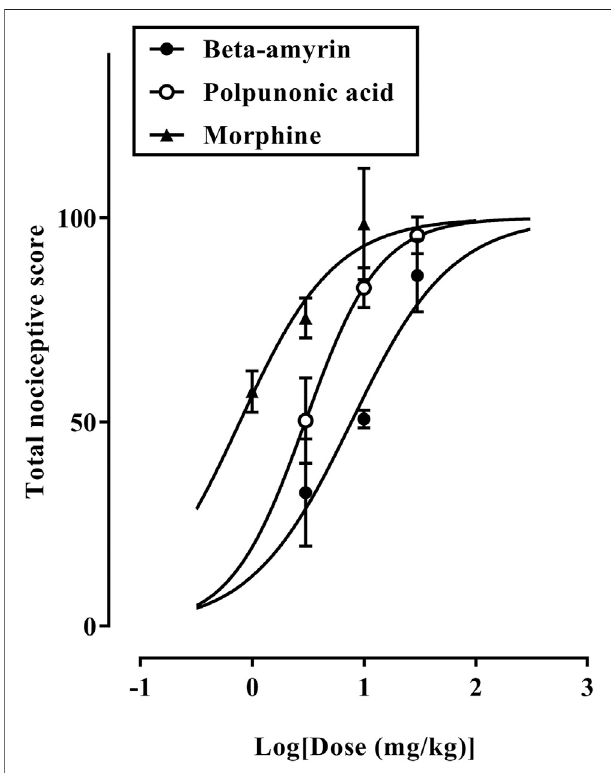
FIGURE 11 | Dose-response curves of β -amyrin, polpunonic acid, and morphine.